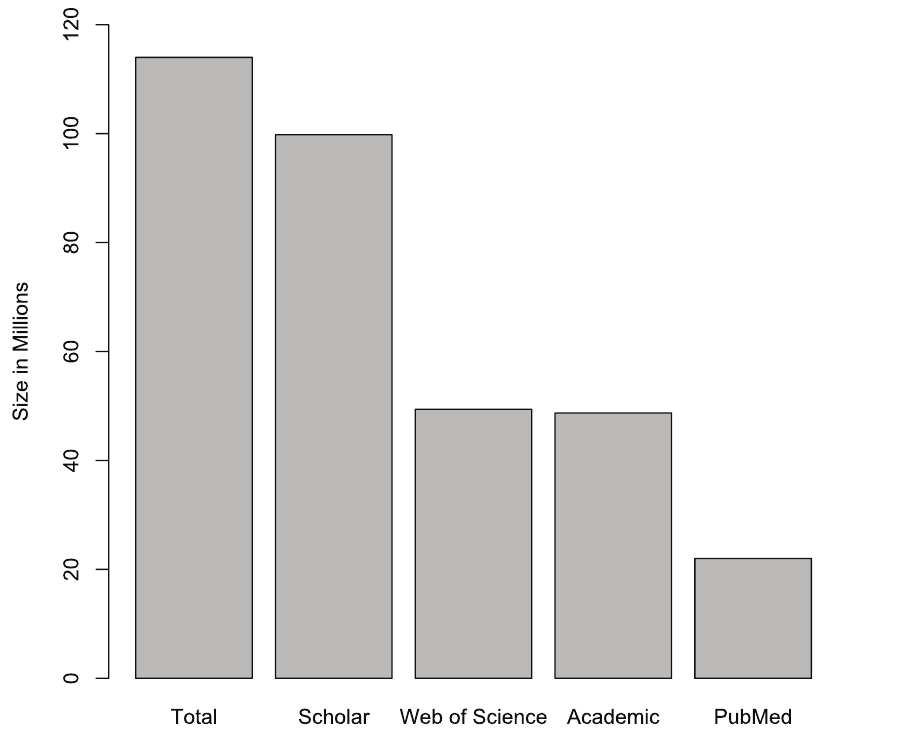
Figure 2. Relative number of documents by scholarly search engines and databases. Total and Google Scholar are estimates.